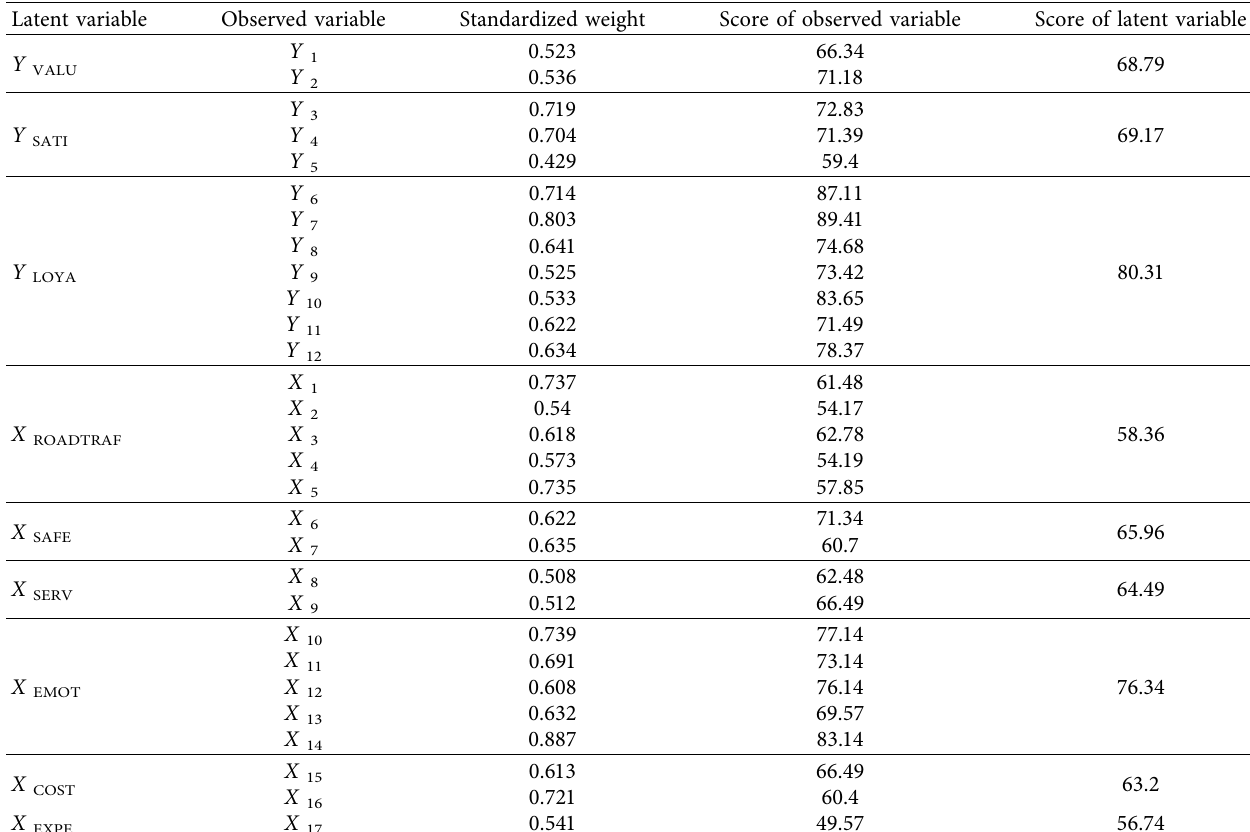
Table 7: Index scores of each